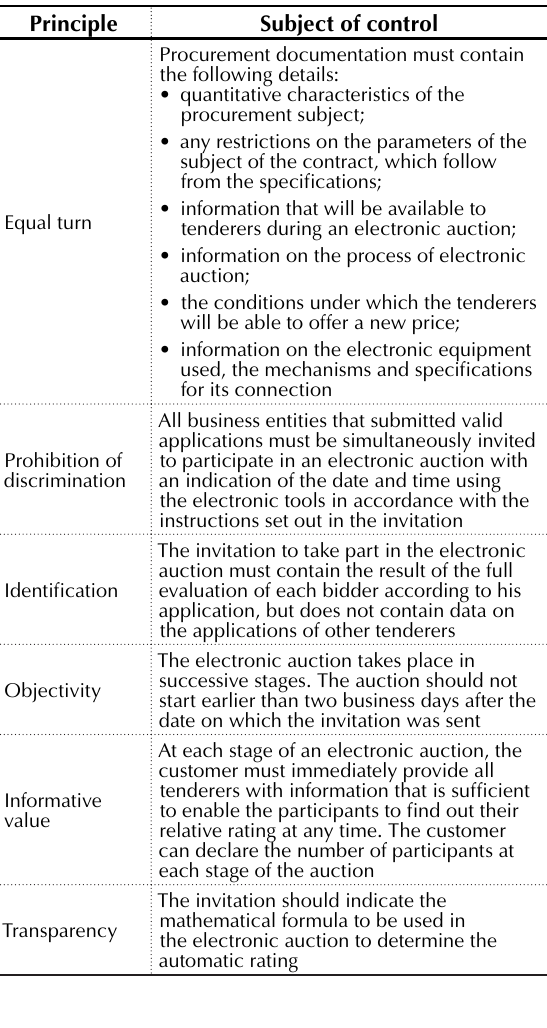
Table 1. Principles of public procurement